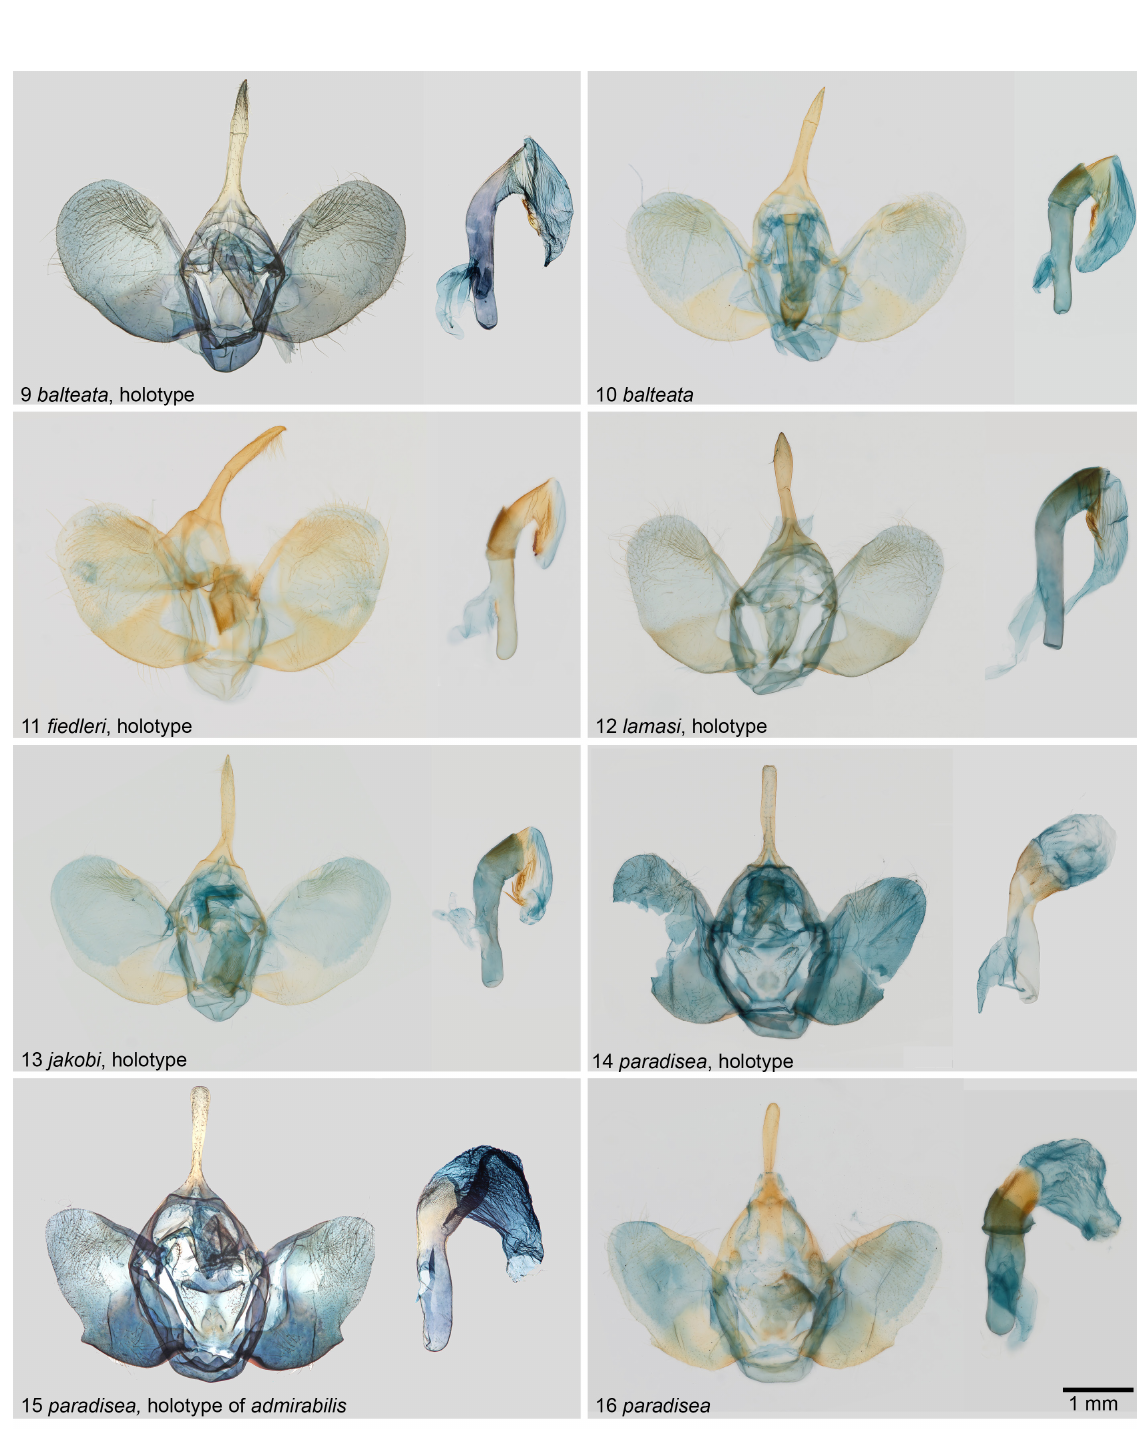
Figs 9–16. Male genitalia (left: valves, right: aedeagus). 9 . Callipia balteata Warren, 1905, holotype. 10 . C. balteata Warren, 1905 (C-0189, COI data). 11 . C. fiedleri sp. nov., holotype (C-0074, COI data). 12 . C. lamasi sp. nov., holotype (C-0075, COI data). 13 . C. jakobi sp. nov., holotype (C-0190, COI data) 14 . C. paradisea Thierry-Mieg, 1904, holotype (C-0194). 15 . C. paradisea Thierry-Mieg, 1904 (holotype of C. admirabilis Warren, 1904) (NHM). 16 . C. paradisea Thierry-Mieg,